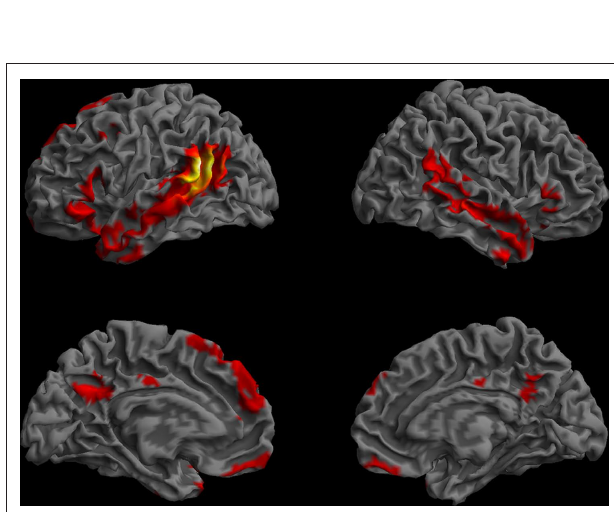
Figure 11 | Pathways associated with the left STS/BA39 region of interest (left, green). Streamline tractography results from two subjects are presented as exemplars. The primary fiber pathway associated with this ROI is